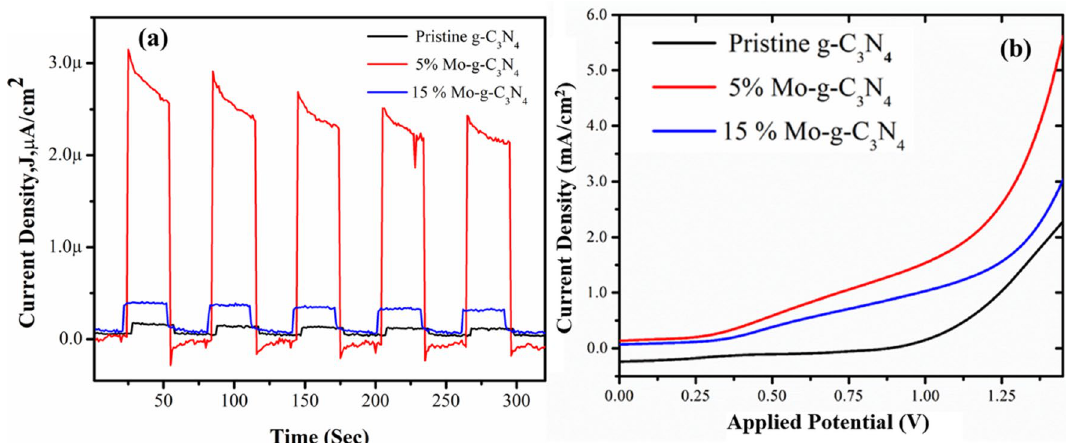
Figure 7. ( a ) The photocurrent profiles recorded for the as-prepared, pristine g-C 3 N 4 and Molybdenum impregnated g-C 3 N 4 samples: pristine g-C 3 N 4 , 5%Mo-CN, and 15%Mo-CN nanotubes. ( b ) The current density vs. applied potential profiles, recorded under 1 SUN irradiation for the pristine g-C 3 N 4 and Molybdenum impregnated g-C 3 N 4 samples using linear sweep